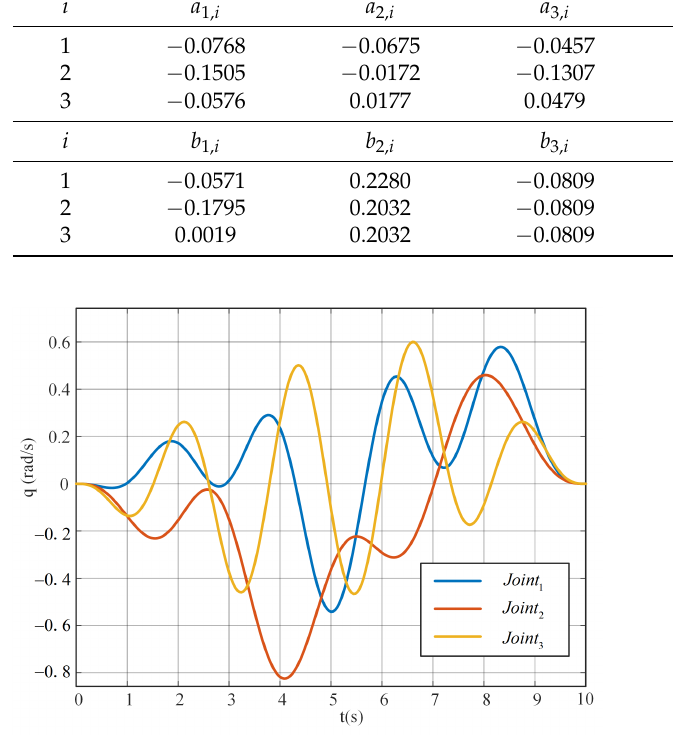
Figure 5. The Fourier series excitation